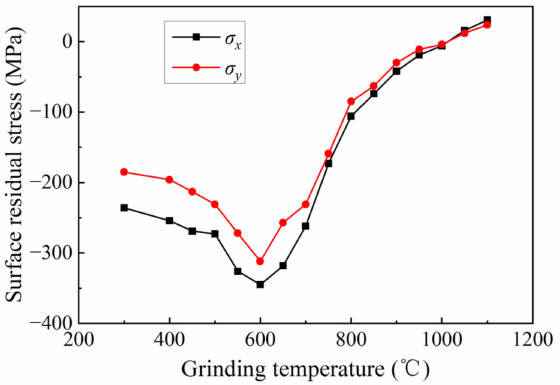
Figure 9. Surface residual stress at different grinding